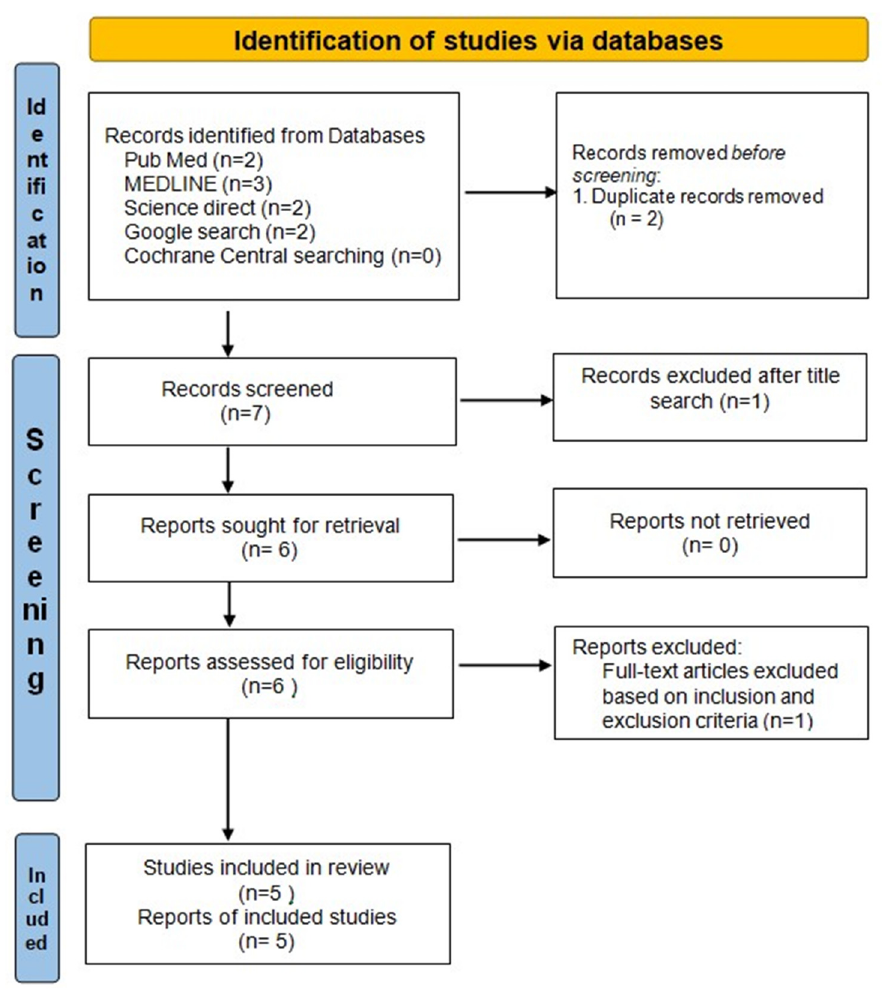
Figure 2. PRISMA Flowchart. Table 1. Characteristics of excluded